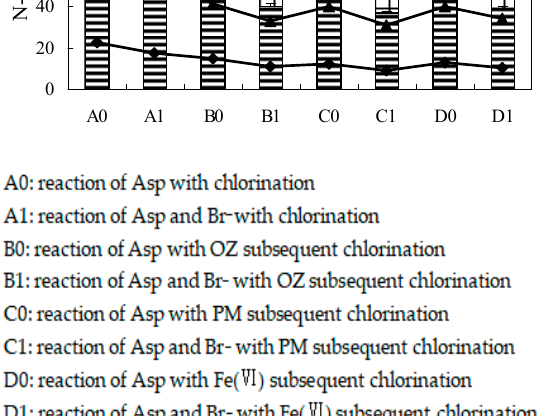
Figure 3. Effect of bromide on the formation of HAN and TCNM during pre-oxidation subsequent chlorination of Asp (Asp = 0.1 mM, oxidant (OZ, PM, and Fe( Ⅵ )) = 5 mg/L, Br _ = 1 mg/L, pre-oxidant contact time = 0.5 h, chlorine contact time = 24 h, pH = 7 ± 0.2 and temperature = 22 ± 1 °C). The bars represent the standard deviation of replicate measurements ( n = 3).